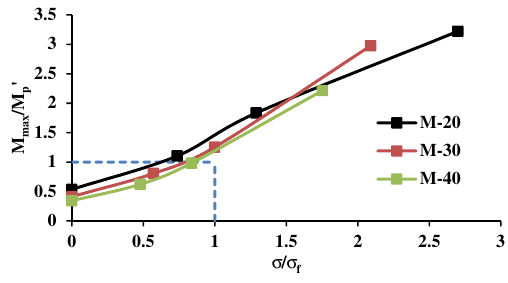
Fig. 22 Bending-buckling interaction graph of 0.5 m diameter pile of various grade of concrete in RCD soil due to the scaled IMV motion